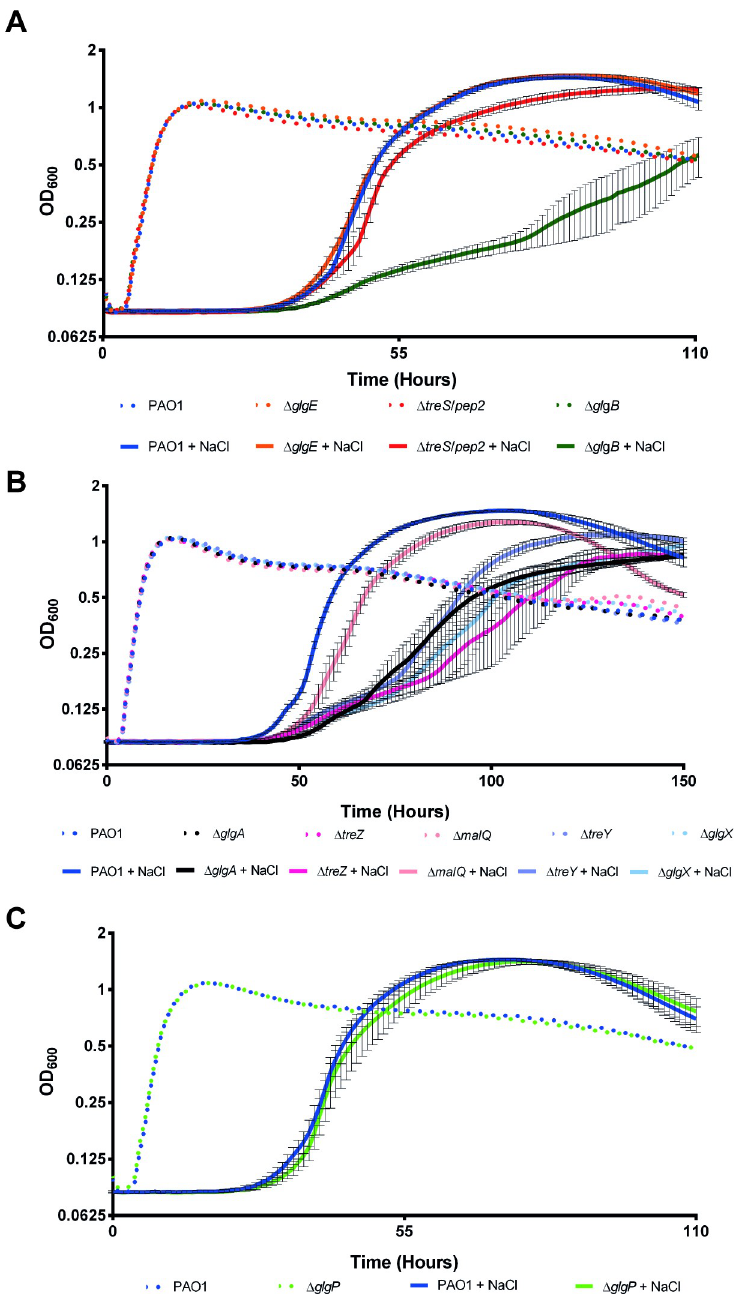
Fig 8. Growth curves of PAO1 mutant strains subject to osmotic stress conditions. OD 600 is plotted against time for strains grown in the presence (+ NaCl, solid lines) and absence (dotted lines) of 0.85 M NaCl. Results are grouped according to the operon in which each set of genes is located: A) Wild-type (WT) PAO1, Δ glgE , Δ treS / pep2 & Δ glgB . B) WT PAO1, Δ glgA , Δ treZ , Δ malQ , Δ treY & Δ glgX C) WT PAO1 & Δ glgP . No growth defect relative to WT PAO1 was observed for any strain grown without NaCl. For strains grown in the presence of 0.85M NaCl, growth defects were seen for Δ glgB , Δ glgA , Δ treZ , Δ treY and Δ glgX . Data are shown +/- standard error of 3 technical replicates. At least two independent biological replicates were conducted per strain and a representative curve is shown in each case.